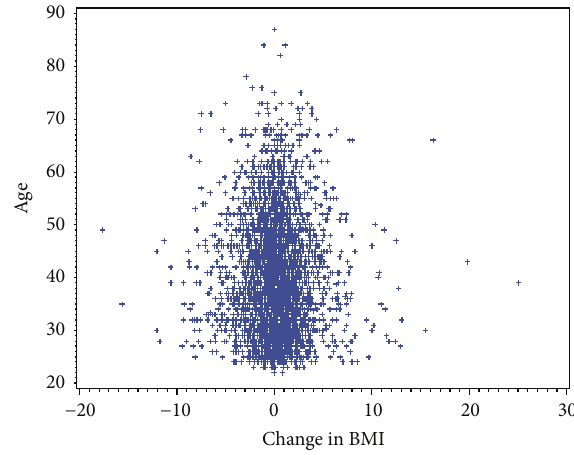
Figure 1: Age distribution for change in BMI.